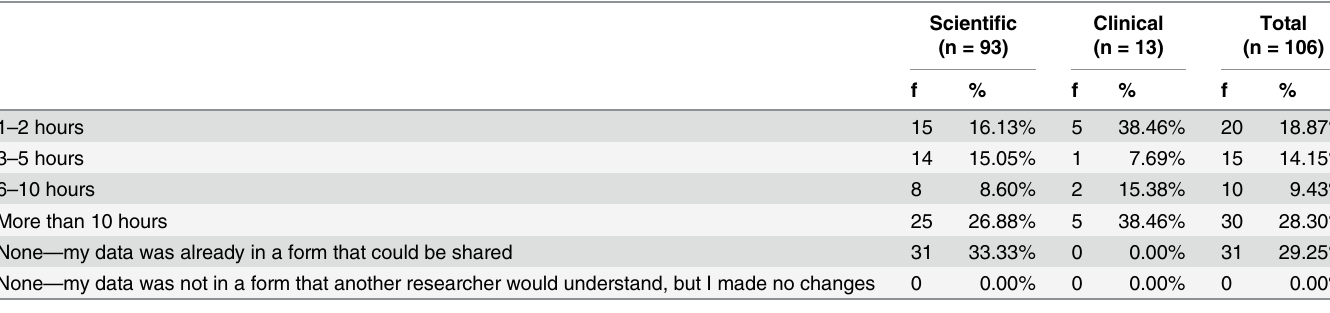
Table 11. Responses to “ How much time did you or your staff spend preparing your data so it would be ready to share or upload?